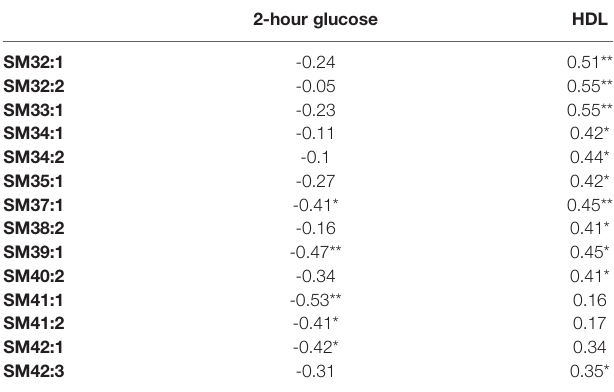
TABLE 4 | Correlations between clinical parameters and level of sphingomyelins before the intervention. 2-hour glucose HDL